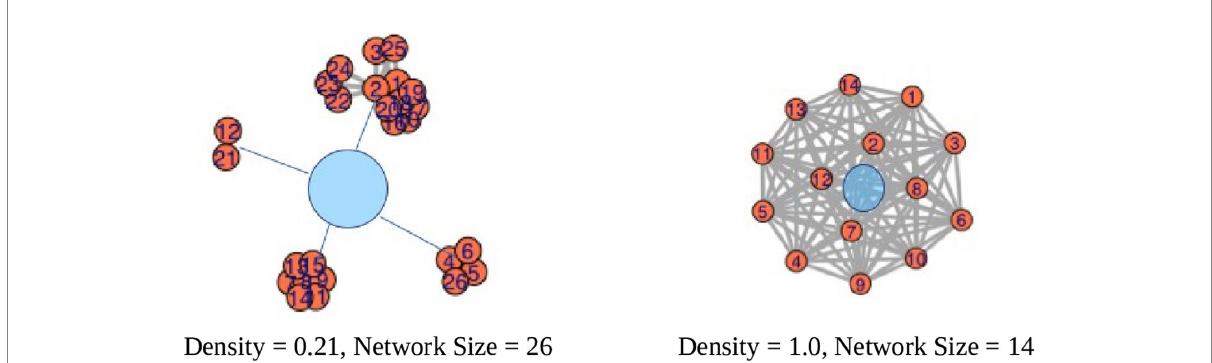
FIGURE 1 Example network graphs. The blue circles represent a child or “ego.” The lower the value, the less connected the social